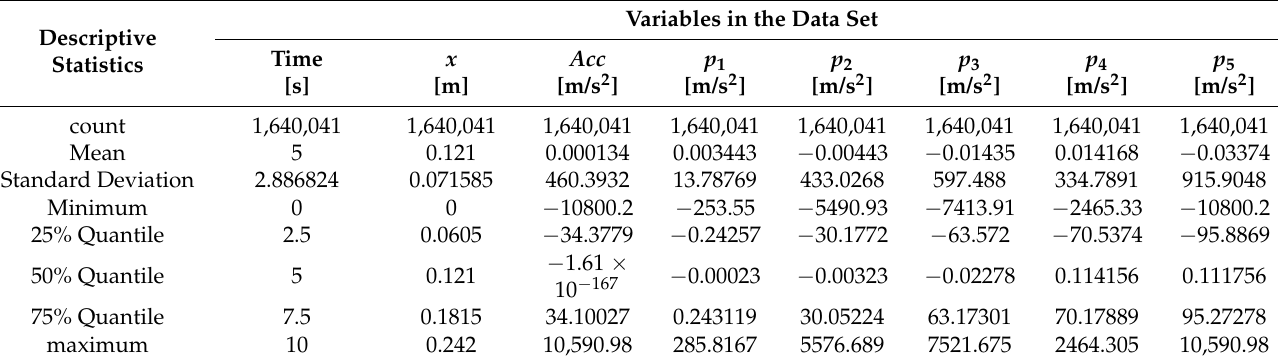
Table 2. Descriptive statistics of the generated data used in the